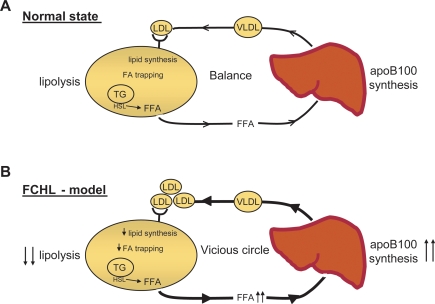
Model for cross-talk between the liver and adipose-tissue.In the normal state there is a balance between production of hepatic apoB100 containing lipoproteins and release of free fatty acid (FFA) from the adipose tissue. In FCHL patients, who have lower noradrenaline-induced lipolysis and increased levels of plasma lipoproteins containing aoB100, lowered lipid synthesis and decreased adipocyte fatty acid trapping lead to elevated levels of FFA in the circulation. Increased levels of circulating FFA activate apoB100 synthesis leading to elevated plasma apoB100 containing lipoprotein levels. In this fashion an imbalance between liver-adipose tissue is created and a “vicious circle” evolves. HSL indicates hormone sensitive lipase.